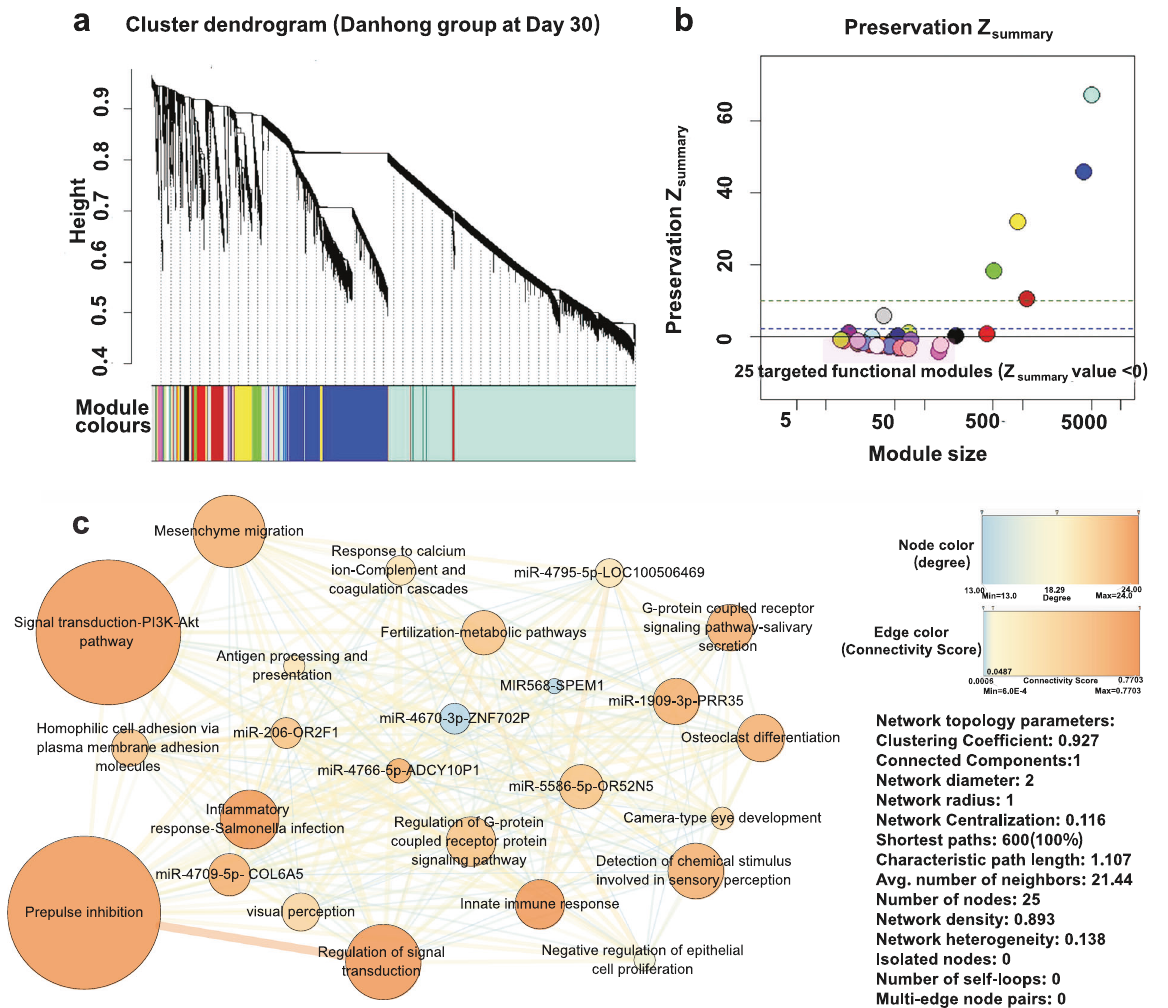
There were 25 differentially expressed modules (DEMs) with negative Z summary values (<0); these modules were considered the targeted functional modules (TFMs). c The 25-TFM map for DHI at Day 30 with the 25 TFMs as nodes and the connectivity score (CS) as the edge between each pair of modules. The node size indicates the number of genes in the corresponding TFM, and the color of the node shows the degree of the TFM in the